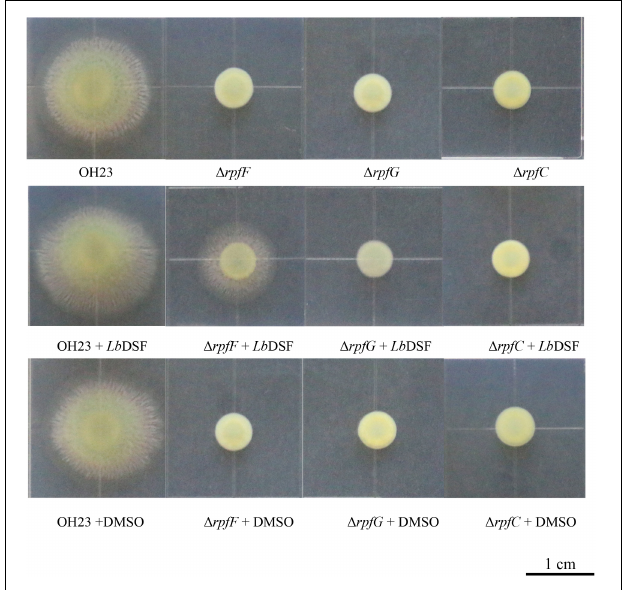
FIGURE 4 | Colony morphology of wild-type OH23 and the rpf mutants on NYG plates with or without the exogenous addition of Lb DSF. Each strain was grown in NYG liquid medium until the OD 600 was approximately 1.0. Then, 3 µ l of each strain was inoculated onto the surface of NYG plates. The plates were incubated at 28 ◦ C for 4 days. For the Lb DSF treatment group, the strains were grown in NYG liquid medium containing 2 µ M Lb DSF, and the NYG plates contained 5 µ M Lb DSF. Each treatment was completed in triplicate, and the experiment was repeated three